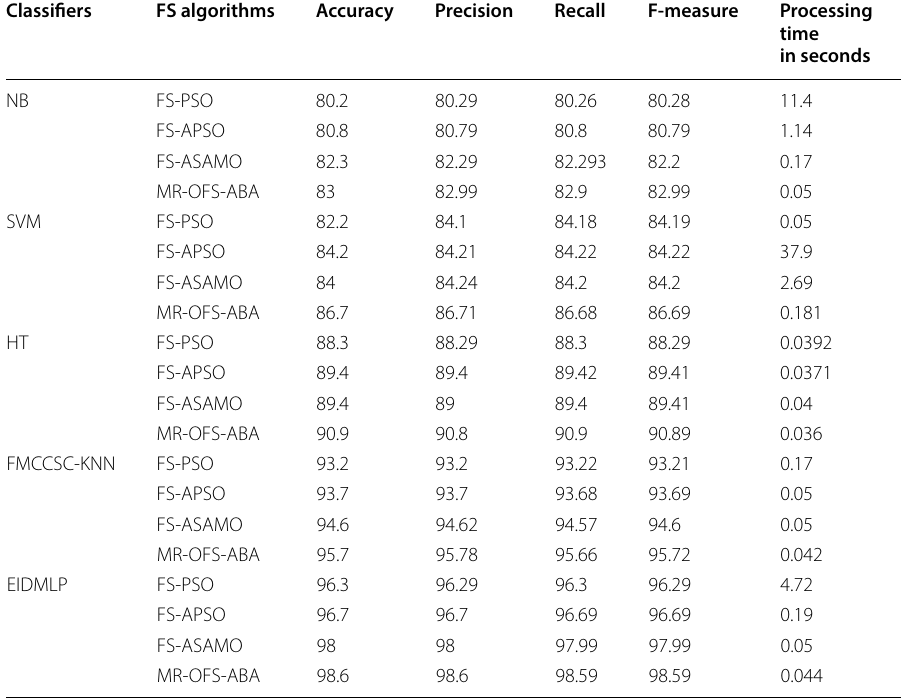
Table 3 Classification results of